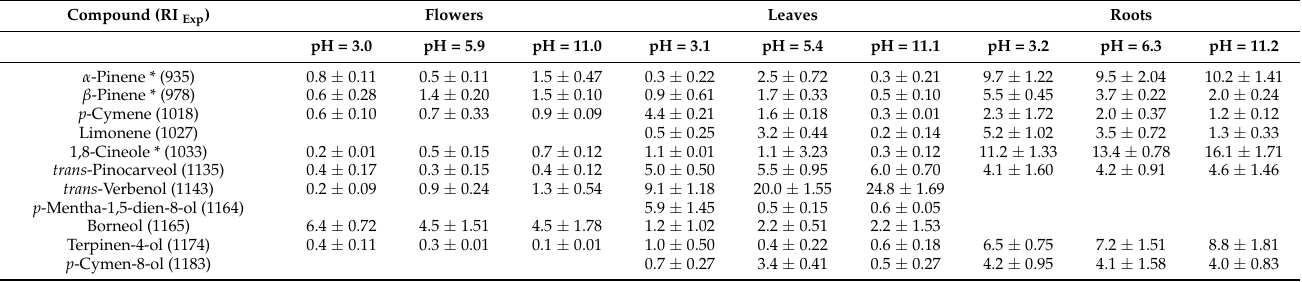
Table 4. Major ( ≥ 3.0%) volatile organic compounds determined in water/diethyl ether Solidago canadensis inflorescence, leaf and root extracts of different acidity (n = 3, average mean ± SD, plants collected from four sites of the investigated